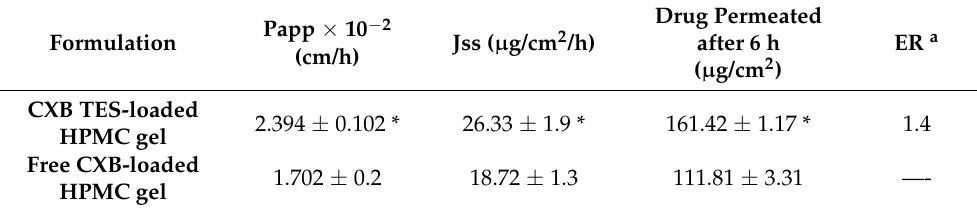
Figure 5. Ex-vivo permeation profile of selected CXB transethosomes-loaded HPMC-based hydrogel (CXB-TES-HPMC gel), in comparison to free CXB-loaded HPMC hydrogel in phosphate buffer (pH 6.8, 1% w/v SLS) at 37 °C. Data are expressed as mean ± S.D. ( n = 3). Table 4. Permeability parameters obtained from ex-vivo permeation studies of CXB TES-loaded HPMC hydrogel versus free CXB-loaded HPMC hydrogel across rat skin.